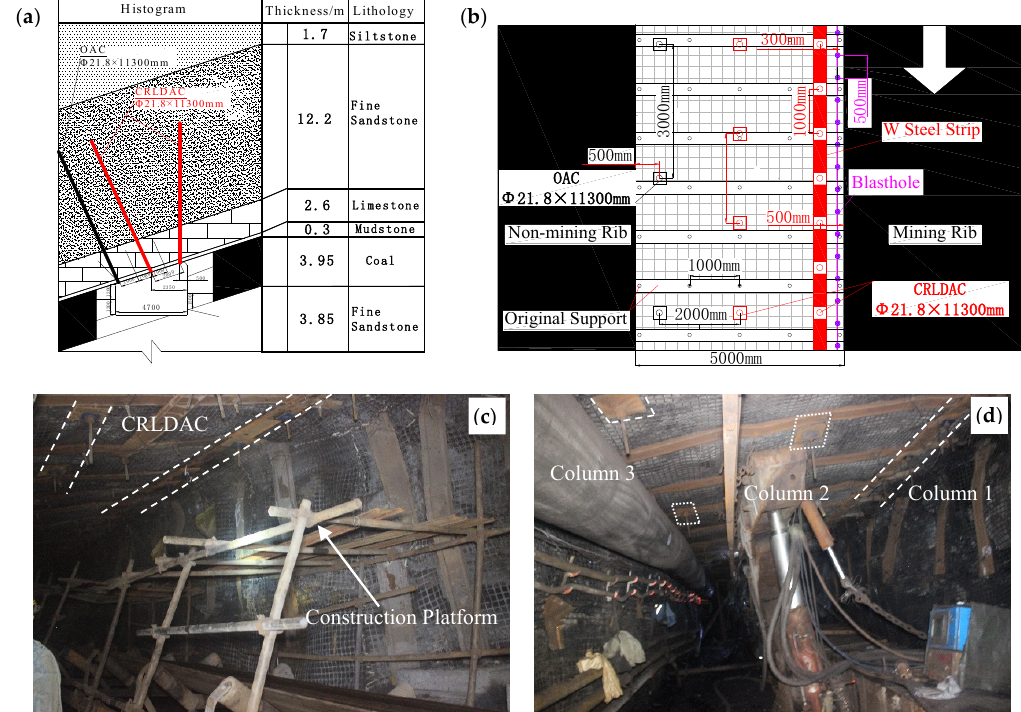
Figure 13. Design and construction of anchor cable: ( a ) profile view; ( b ) plan view; ( c ) construction platform; ( d ) effect of construction.